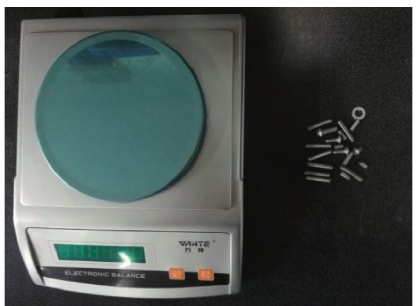
Figure 5: Electronic balance and small screws for correction masses.